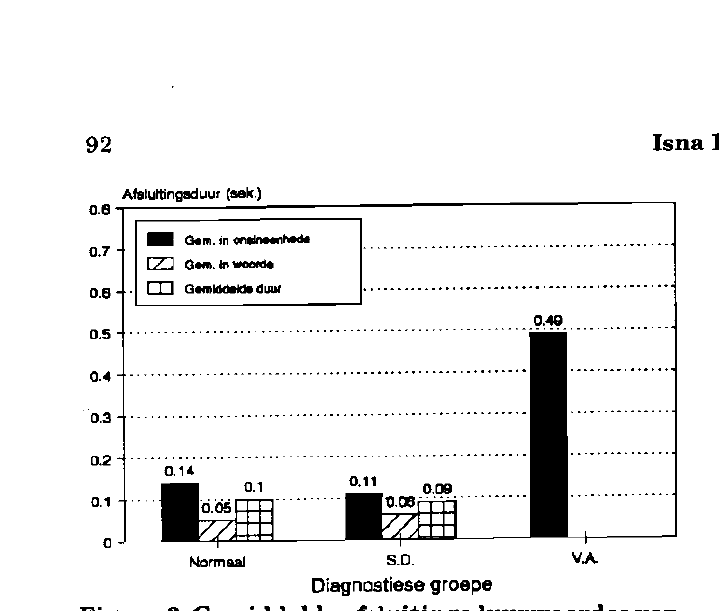
Figuur 2. Gemiddelde afsluitingsduurwaardes van